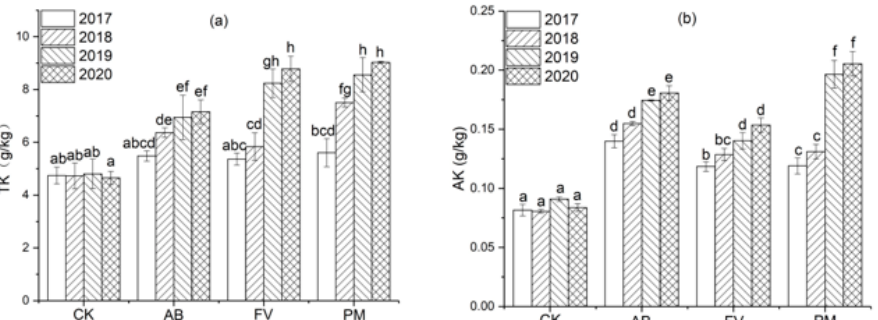
Figure 4. ( a ) Effects of the different fertilizer treatments on the content of TK in the soils; ( b ) Effects of the different fertilizer treatments on the content of AK in the soils. Data are expressed as means ± SD; n = 3. Different letters on data in the same group indicate a significant difference between them at p < 0.05 level.